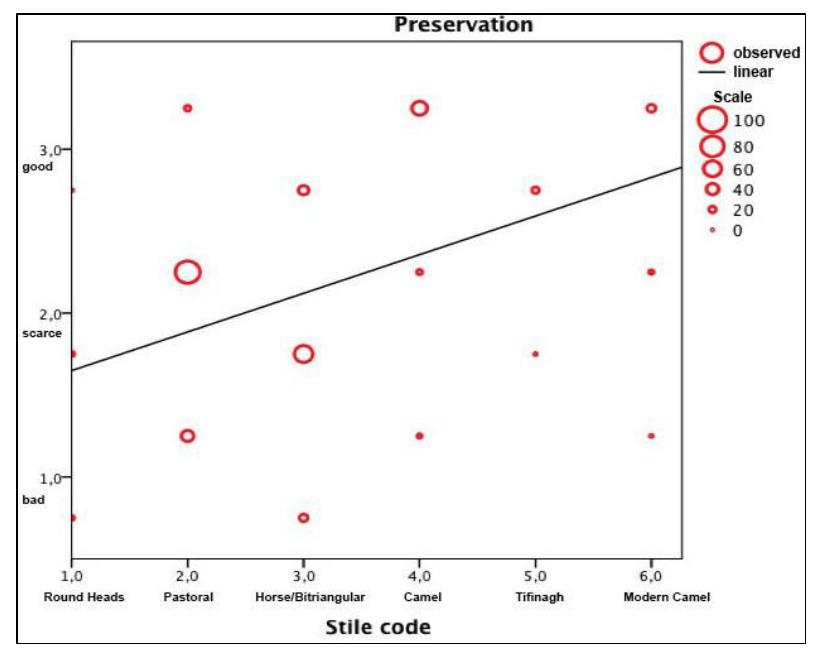
Figure 11. Graph representing the quantitative relation between styles (sorted by relative age) and state of preservation; the linear trend shows the correlation between preservation and